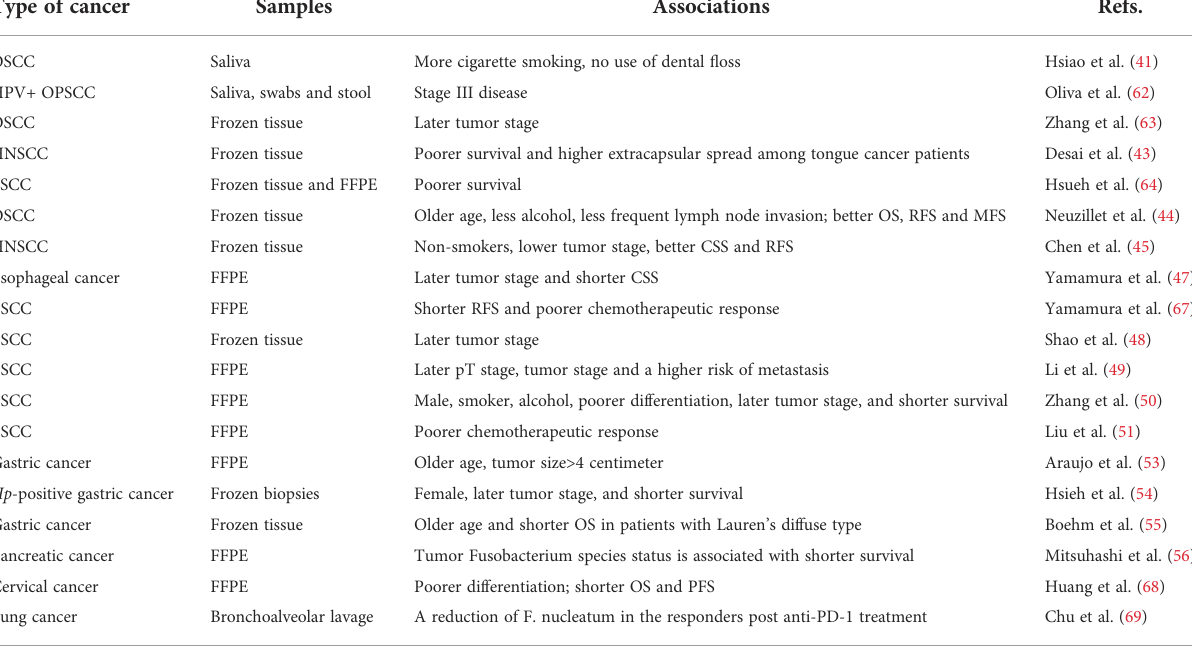
TABLE 2 Summary of publications showing the associations between clinicopathological features and F. nucleatum positivity in malignancies except for colorectal cancer. Type of